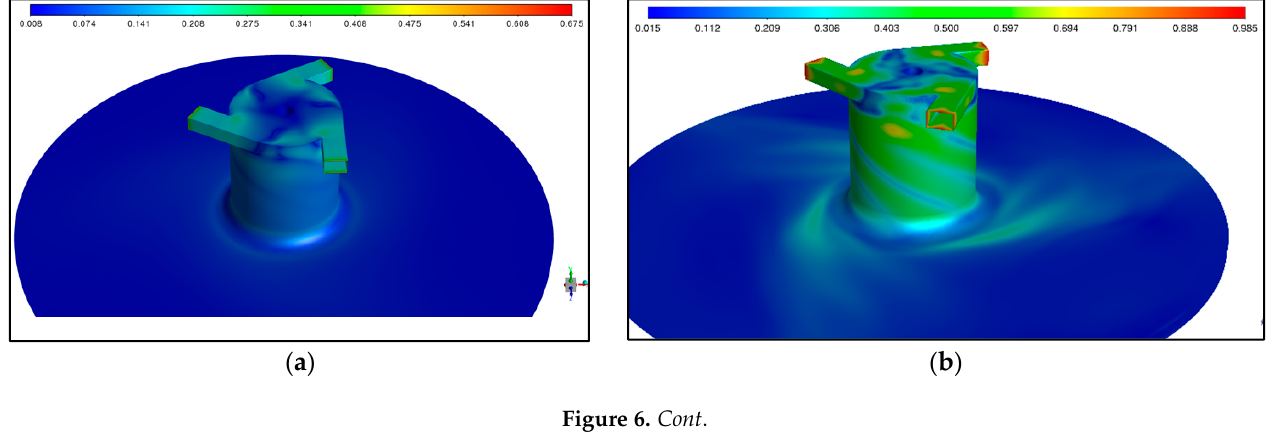
2 ; and ( c ) inviscid air .